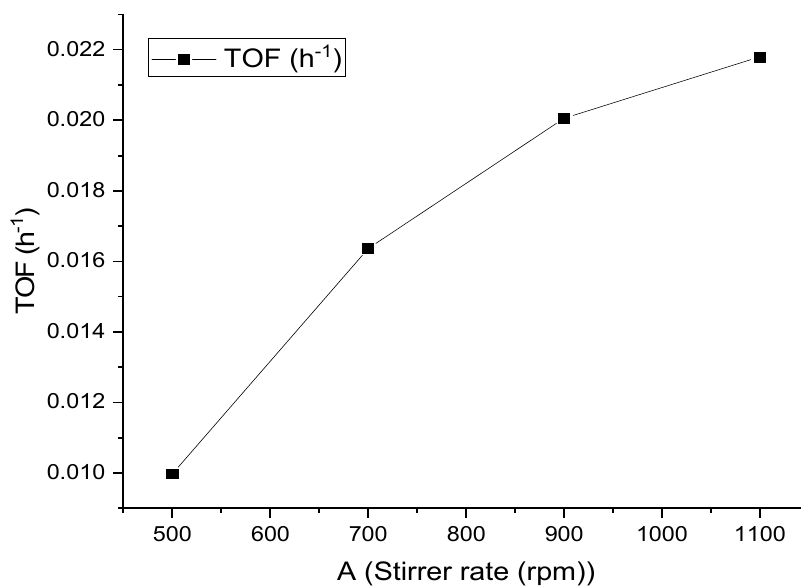
Figure 7. Turnover frequency of FA decomposition over 1%Ir:2%Pd/C. Reaction conditions: FA (0.5 M), catalyst (0.1 g; substrate:metal molar ratio = 137:1), and 240 min.